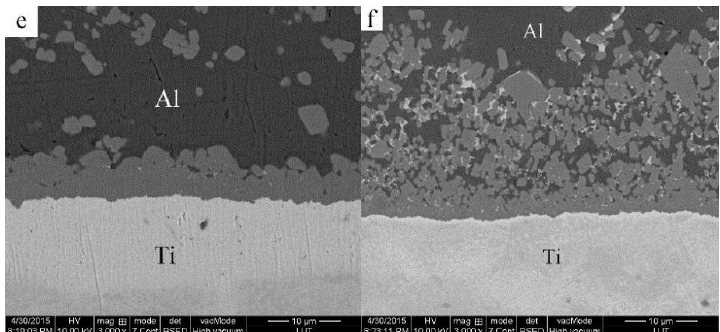
Figure 14. SEM micrographs of the Al-Ti interface after heating at 640 °C for different lengths of time: